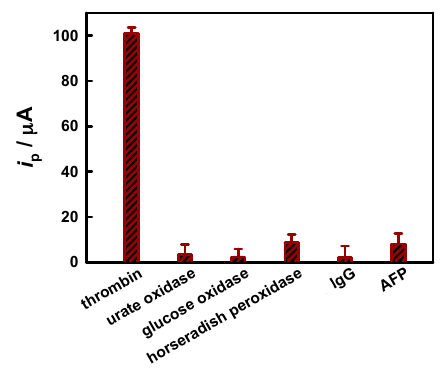
Figure 6. The responses of the prepared aptamer-electrode to 10 nM thrombin and several other proteins each at 1 μ M. Table 2. Detection of thrombin in the human blood serum substrate ( n = 3) by our method. The sera were 10-fold diluted with Tris-HCl buffer (pH = 7.4).